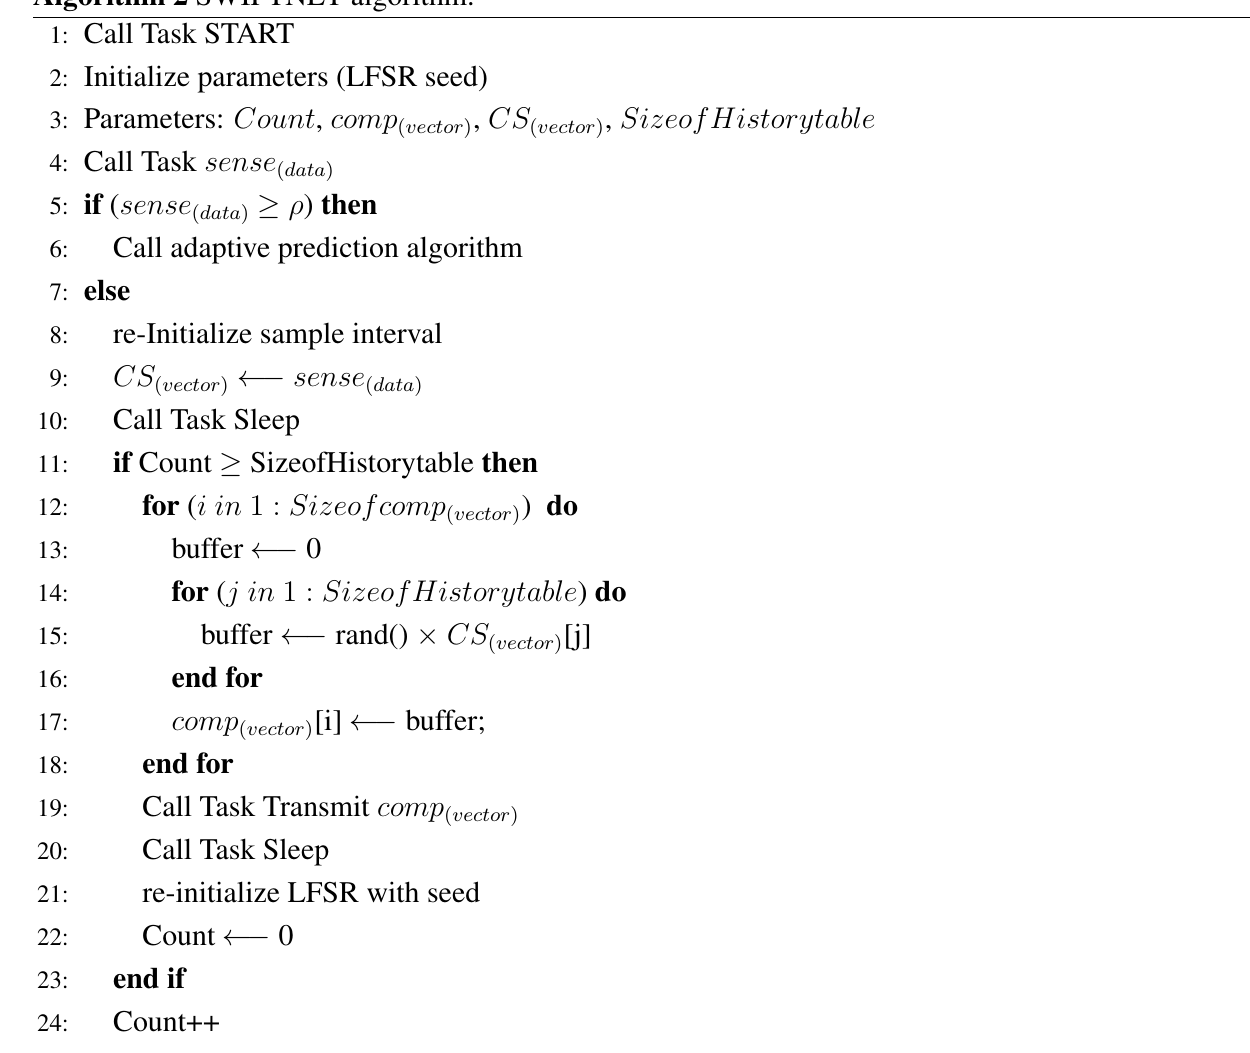
Figure 7. Experimental testbed topology. Algorithm 2 SWIFTNET